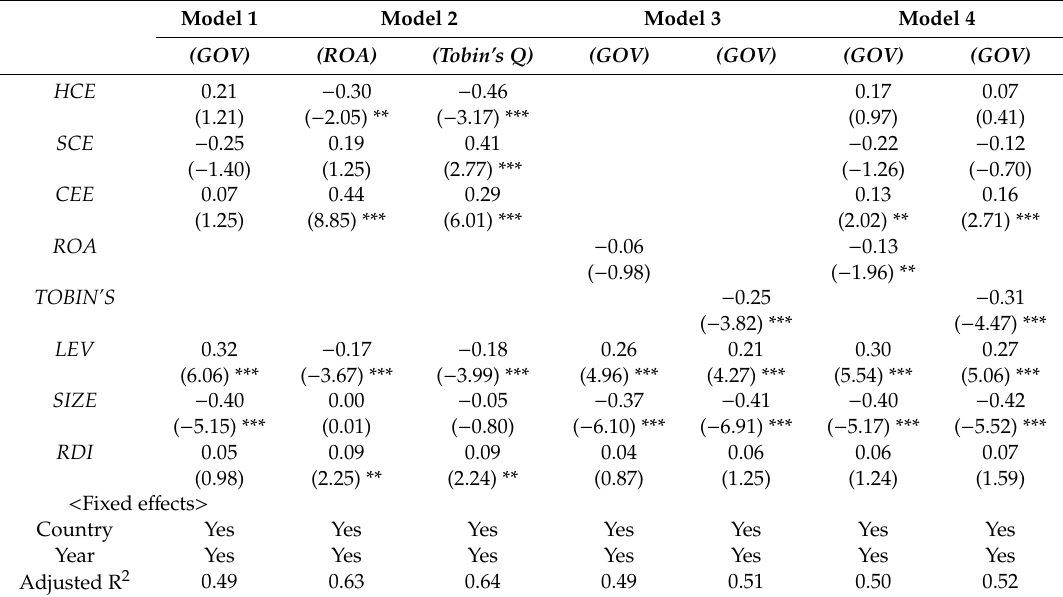
Table 5. Mediating e ff ect of financial performance (IC and